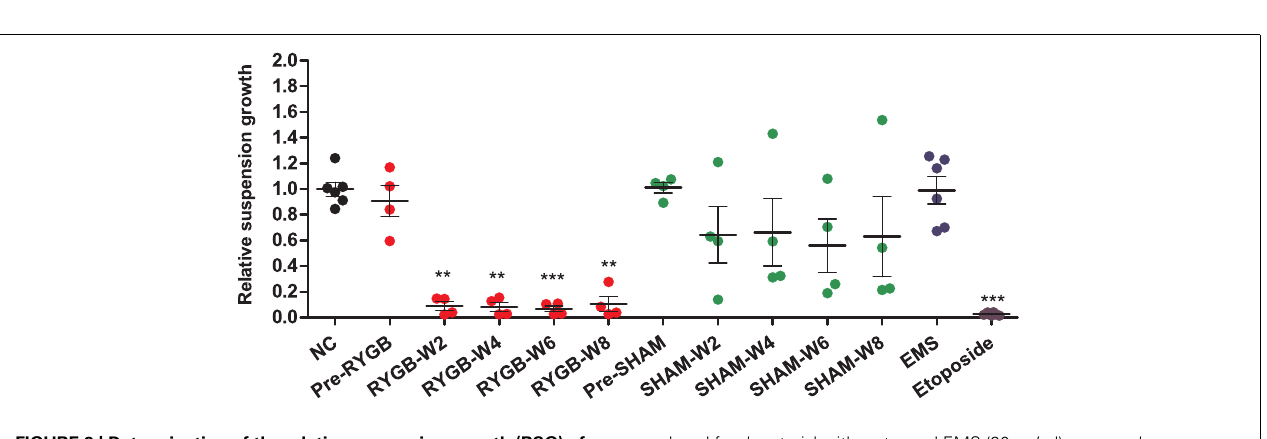
FIGURE 1 | Determination of the relative suspension growth as a measure of cytotoxicity (A) and genotoxicity (B) of fecal water extracts following treatment of L5178Y mouse lymphoblastoid cells for 24h. Data